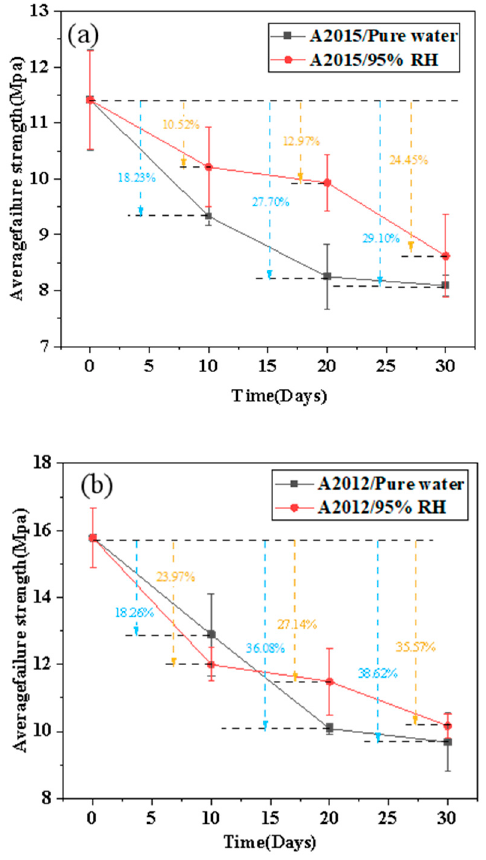
Figure 8. Effect of hygrothermal aging on the strength of single lap joint: ( a ) A2015 and ( b ) A2012.